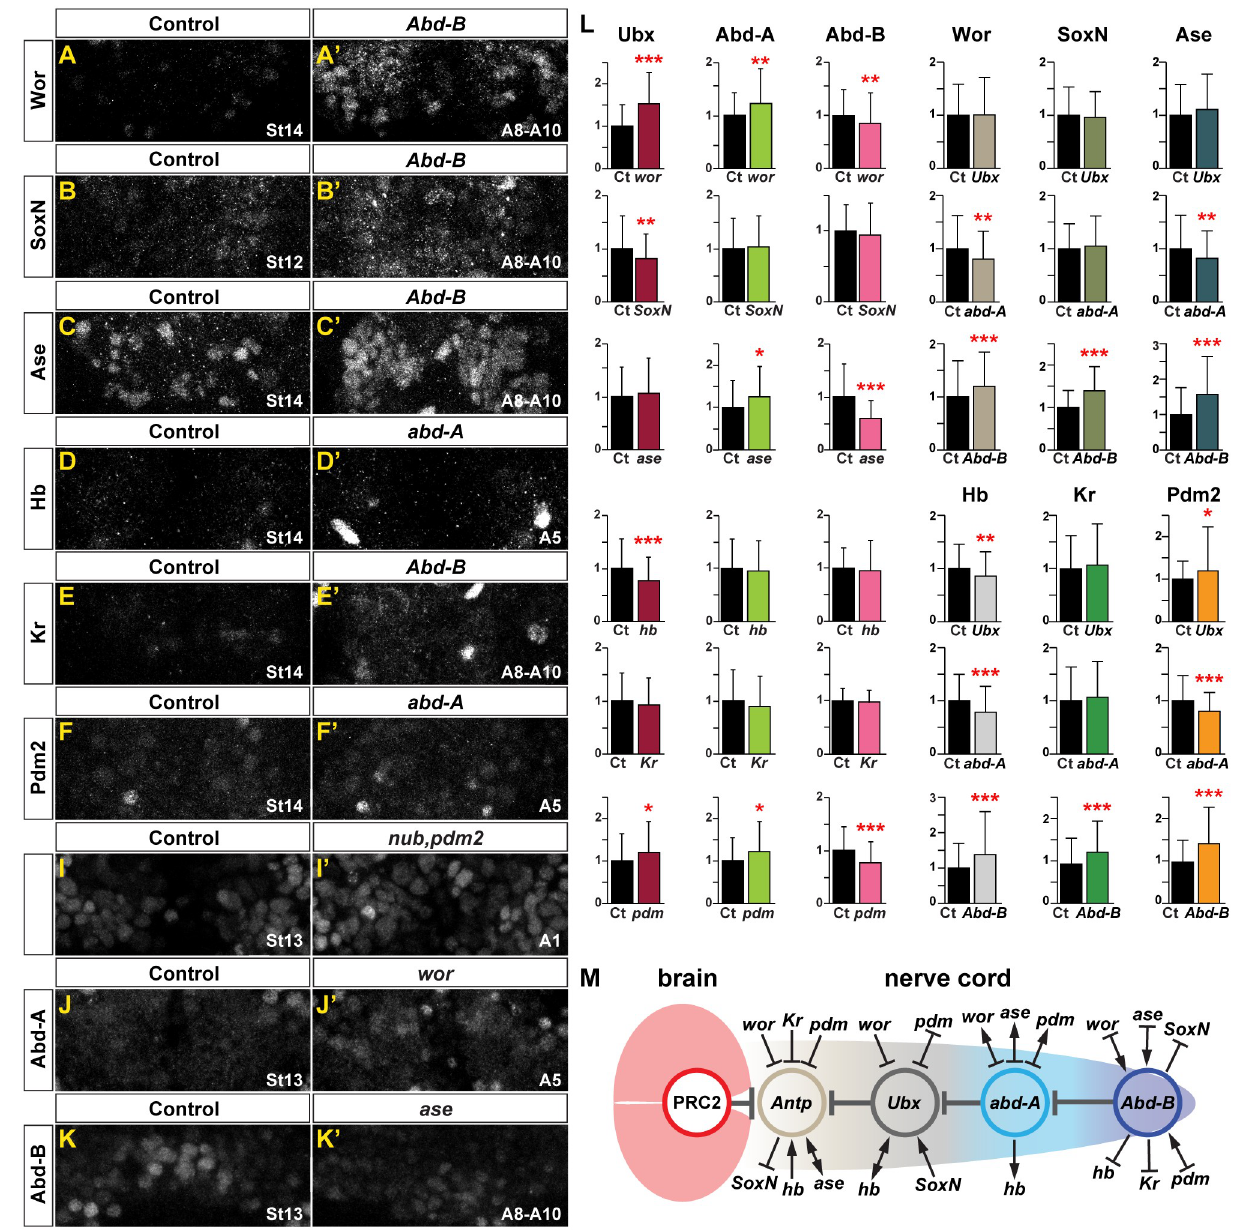
Fig 3. EFs and Hox genes regulate each other. (A–K 0 ) Expression of Hox factors and EFs in control as well as in Hox and EF mutants. (L) Quantification of staining intensity of Hox factors and EFs in NBs in control and in EF and Hox mutants (see Materials and methods for details). St13 for Hox levels, St12 for SoxN levels, and St14 for the other five EF levels. Segments A1 for Ubx levels and Ubx mutants, A5 for Abd-A levels and abd-A mutants, and A8–A10 for Abd-B levels and Abd-B mutants ( � p � 0.05, �� p � 0.01, ��� p � 0.001, Student two-tailed t test; n = 3 CNSs; ± SD). (M) Cartoon summarizing the identified cross-regulation between Hox genes and EFs, based upon data herein and previous studies [21]. The numerical data underlying this figure are included in S1 Data. Genotypes: Control = OregonR . Ubx = Ubx 1 / Df(3R)Ubx109/Dp(3;3)P5 . abd-A = abd-A MX1 . Abd-B = Abd-B D18 . ase = Df(1)ase-1 . SoxN = SoxN NC14 /Df(2L)Exel7040 . wor = wor 4 /Df(2L)ED1054 . hb = hb P1 , hb FB . Kr = Kr 1 , Kr CD . nub , pdm2 = Df(2L)ED773 . abd-A , abdominal-A ; Abd-B , Abdominal-B ; Ase , Asense ; CNS, central nervous system; Ct, Control; Dpn, Deadpan; EF, Early Factor; Hb, Hunchback; Hox, Homeobox; Kr, Kruppel; NB, neuroblast; Pdm, POU domain; PRC2, Polycomb Repressor Complex 2; SoxN, SoxNeuro; St, Stage; Ubx , Ultrabithorax ; Wor, Worniou.